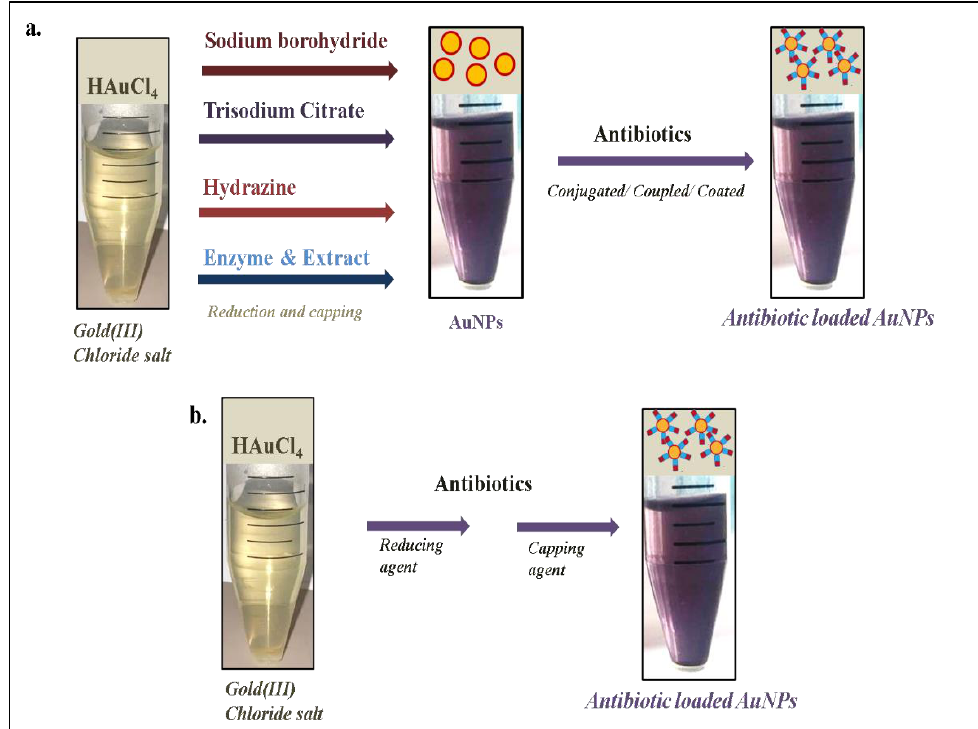
Figure 2. Various approaches used for the synthesis of antibiotic-loaded AuNPs. ( a ) Two or multi- step approach, ( b ) a single-step approach. approach, ( b ) a single-step